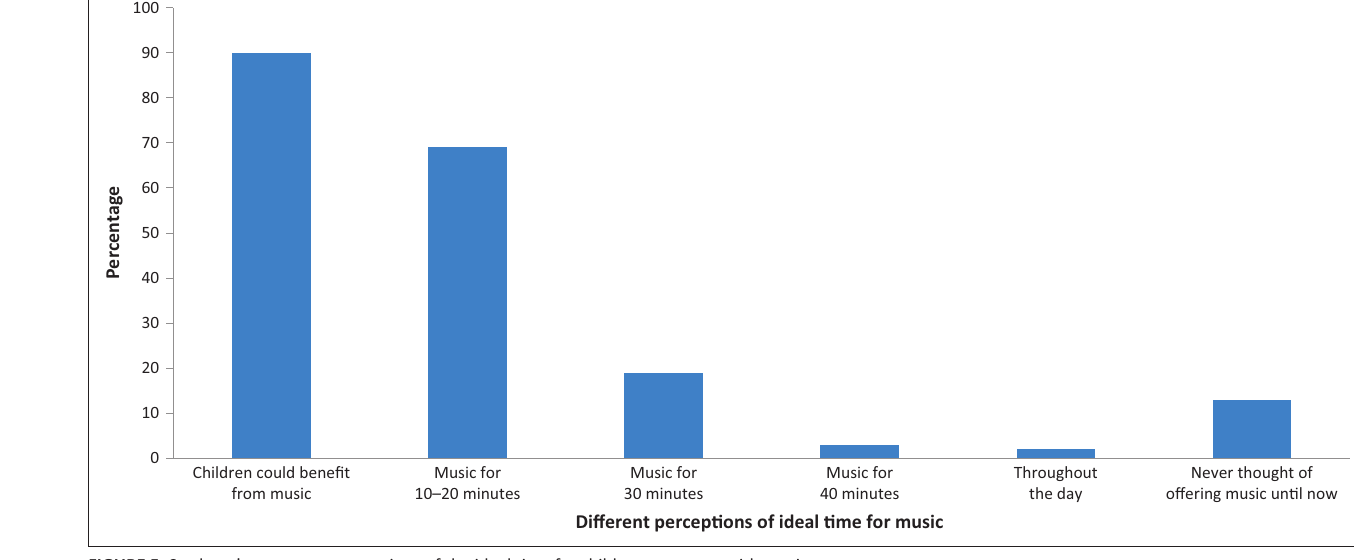
FIGURE 5: Students’ pre-course perceptions of the ideal time for children to engage with music.